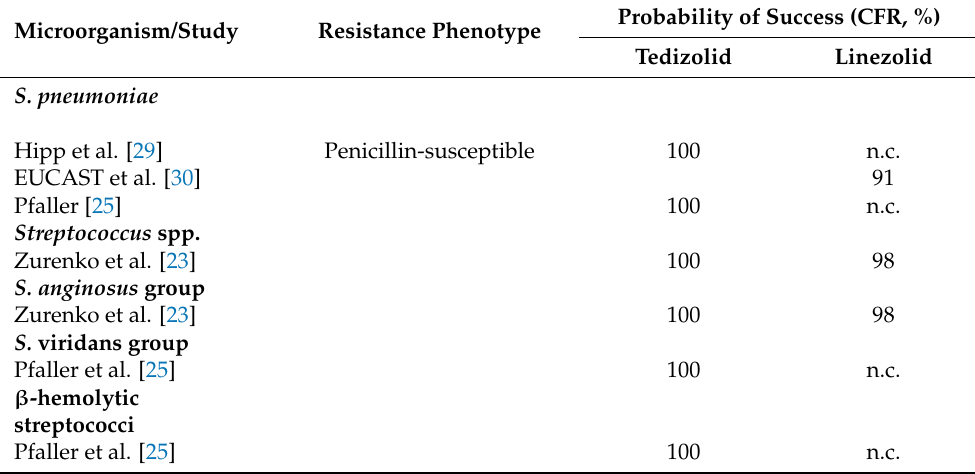
Table 7. Probability of success (expressed as CFR or cumulative fraction of response) of tedizolid and linezolid for